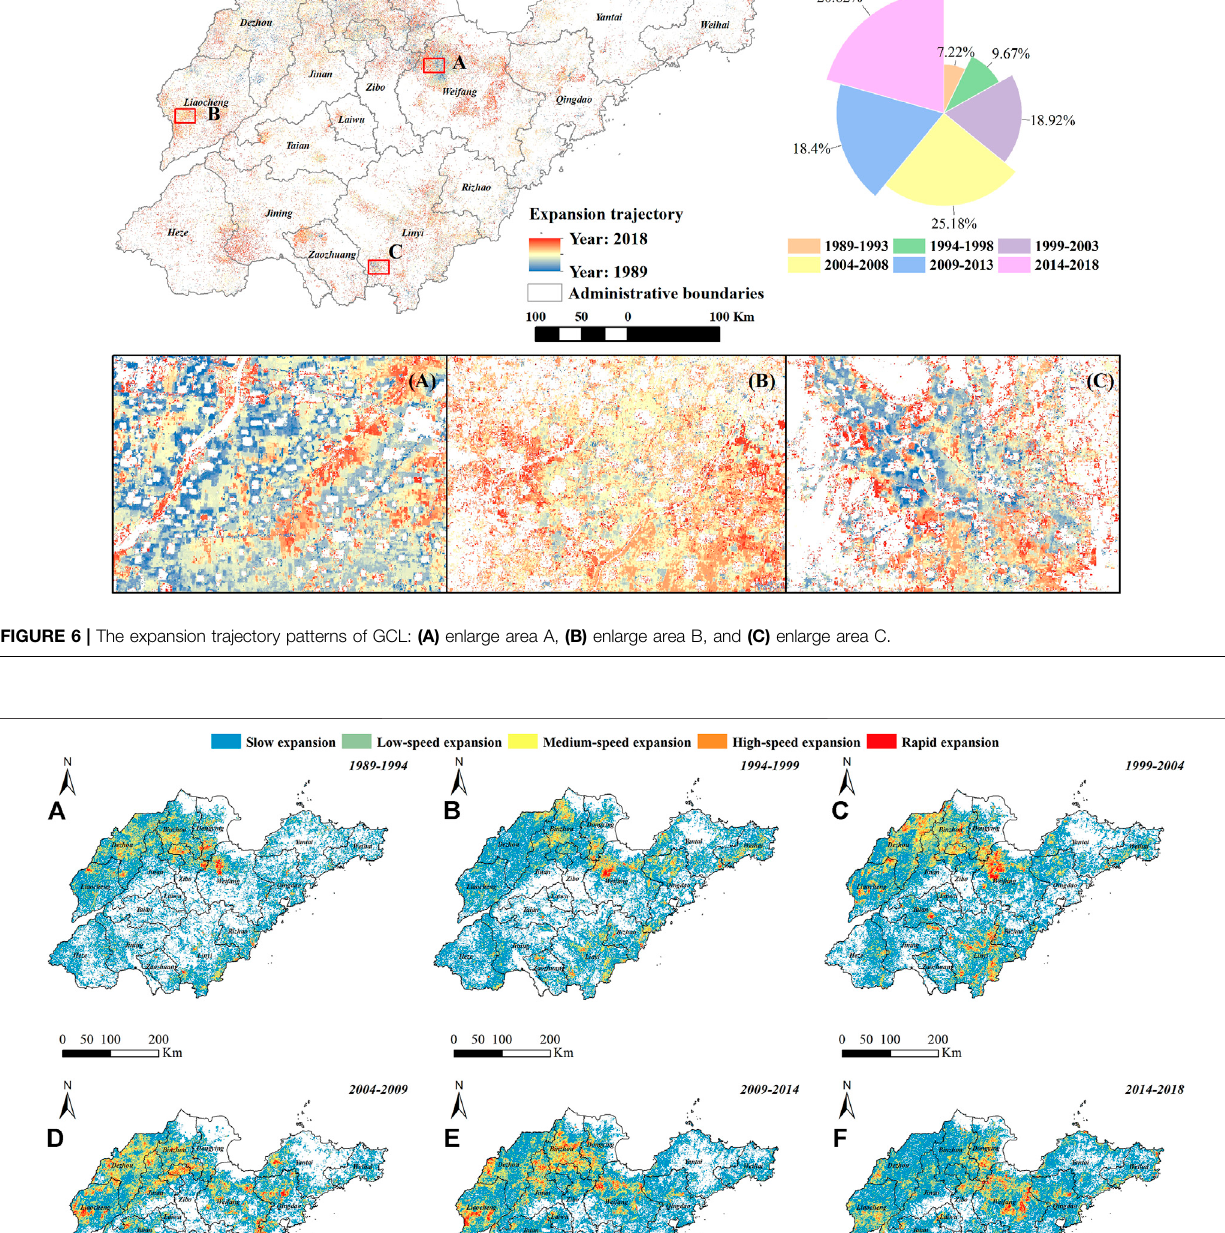
Frontiers in Environmental Science |